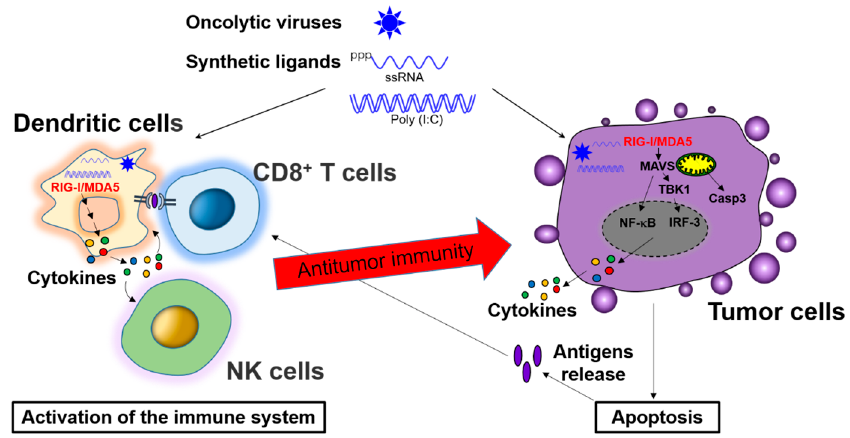
Figure 3. Role of the RIG-1-like Receptors (RLRs) signaling pathway in antitumor immunity. Triggering of RLRs signaling by using oncolytic viruses or synthetic ligands in tumors cells can directly induce tumor cell death via interferon (IFN)-dependent or -independent manner. In addition, these agents are also sensed by host immune cells (primarily dendritic cells), resulting in activation of cluster of differentiation 8 + (CD8 + ) T cells or natural killer (NK) cells, which exhibit an antitumor immune response. RLRs-mediated chemokines and cytokines production in the tumor site also contributes to recruitment of effector T cells. Tumor associated antigens from apoptotic tumor cells are presented to CD8 + T cell for producing tumor-antigen-specific cytotoxic CD8 + T cells.